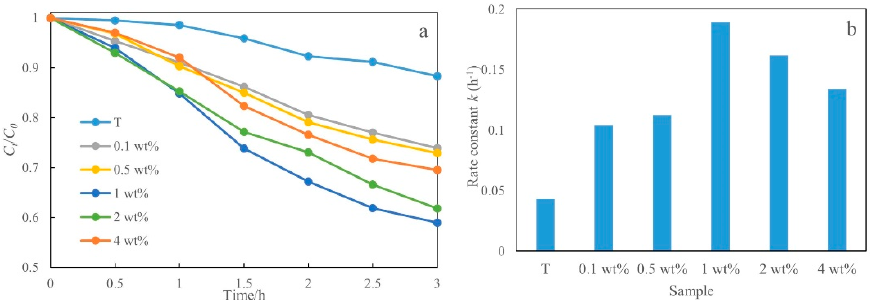
Figure 6. Photocatalytic activity for the degradation of methylene blue over different films: ( a ) degradation with respect to time and ( b ) rate constants.